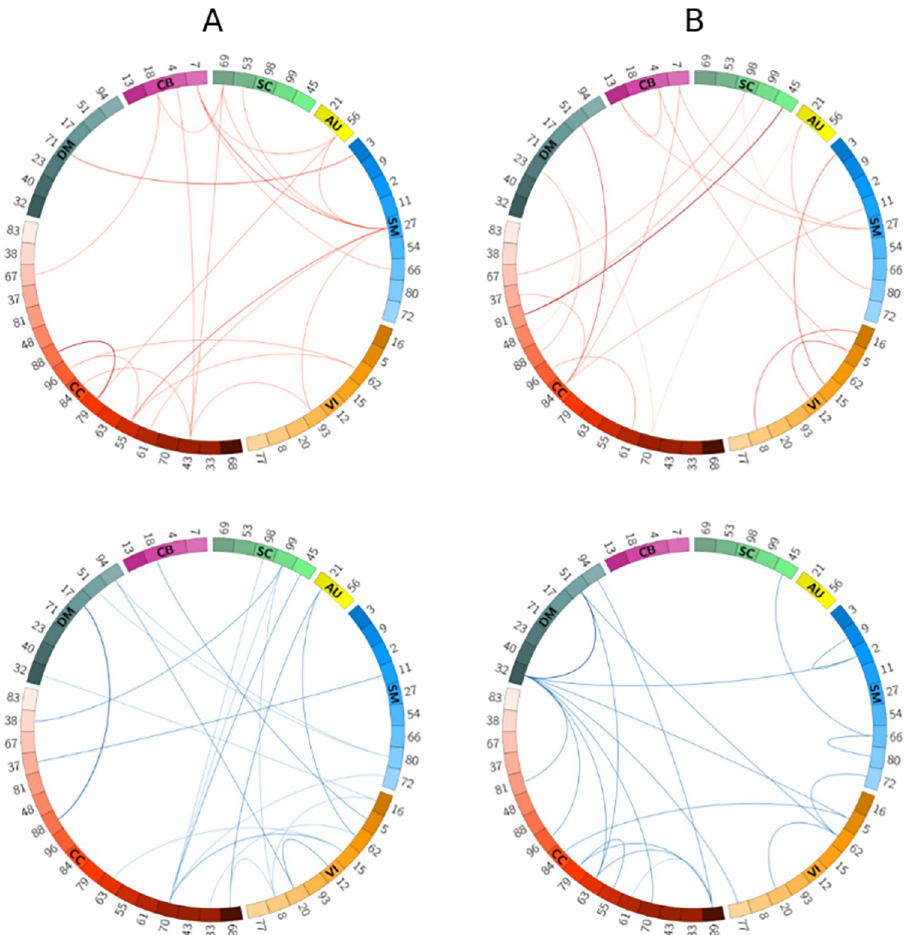
Fig 6. Spatial connectogram of difference in sensitivity (A) as well as the difference in specificity (B) between sex- based groups highlighting the top 1% positive (top row) and negative (bottom row) differences. Fig 6A: scores are calculated by subtracting sensitivities of the female subcohort from the male subcohort. SM27, when paired with other domains, produces higher specificity in males, while CC70 yields higher specificity in females. Fig 6B: scores are calculated by subtracting specificities of different-sex from same-sex subcohorts. The SM and CB networks produce higher sensitivities for different-sex samples, whereas the CC networks predict better in the same-sex subcohort. Blue and red color lines represent the two ends of the difference spectrum. Numbers represent indices for the ICA-derived Neuromark RSNs. The connectograms were generated using the Circos tool [51].